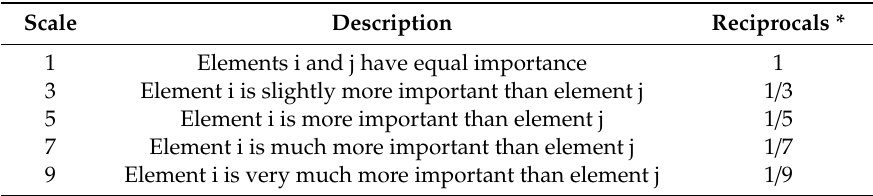
Table 5. Pairwise comparison importance scale